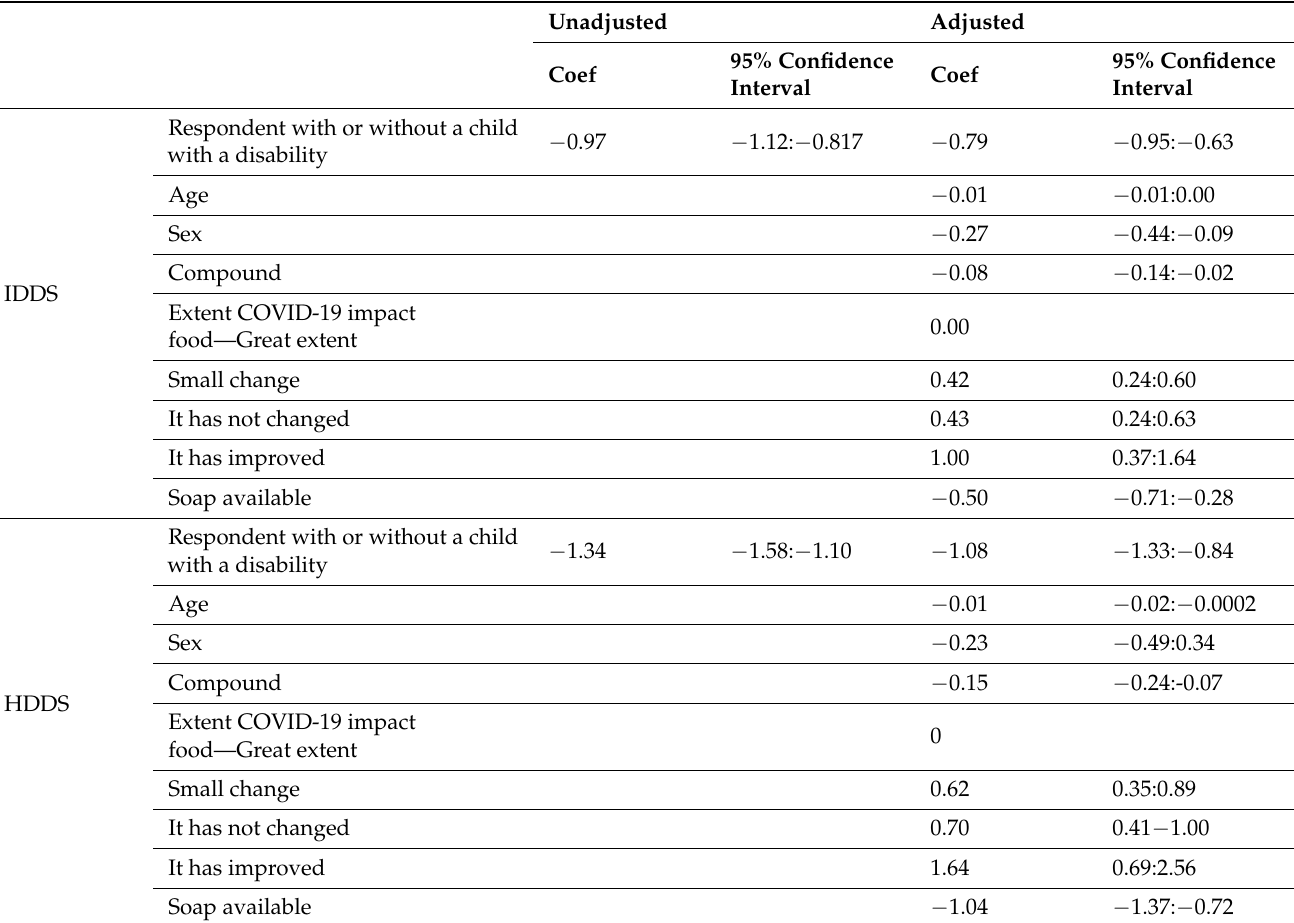
Table 3. Unadjusted and adjusted linear regression models comparing dietary diversity scores between families with and without a child with a disability, Lusaka Zambia 2021. Unadjusted Adjusted 95% Confidence 95% Confidence Coef Coef Interval